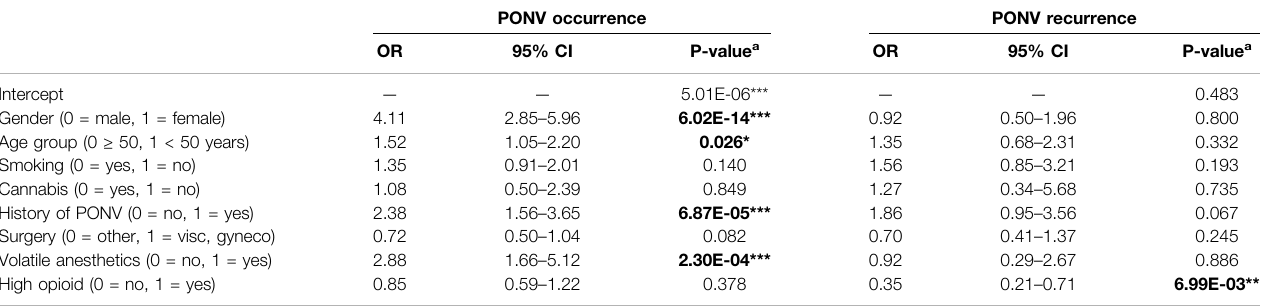
TABLE 3 | Logistic regression model based on dichotomous clinical factors. PONV occurrence PONV recurrence